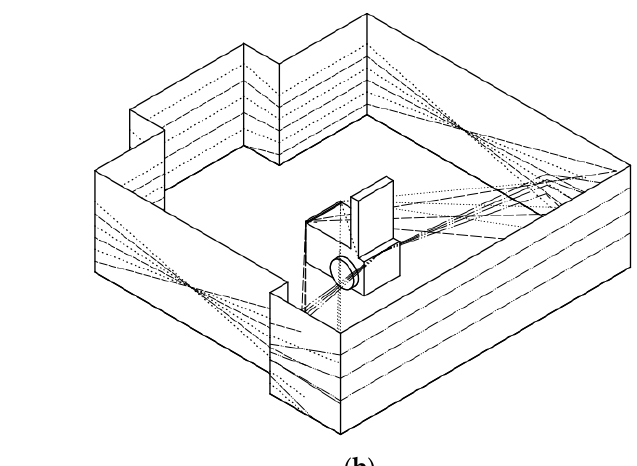
Figure 7. Arrangement of scanning devices in the wheelchair.